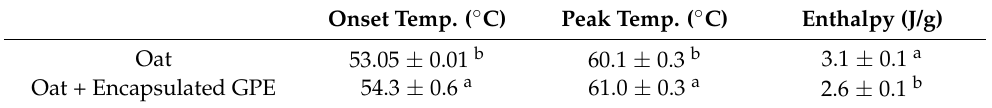
Table 6. DSC gelatinization properties of oat flakes and oat flakes enriched with encapsulated GPE. Onset Temp. ( ◦